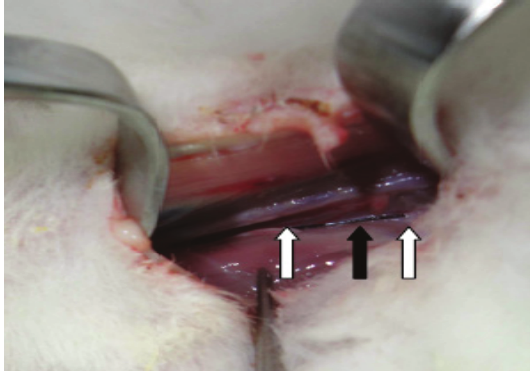
FIGURE 3 - Discontinuity of nerve in the section group. Note: In the area of the discontinuity of the nerve was placed suture in black (black arrow), while the white arrows indicate the ends of the section.